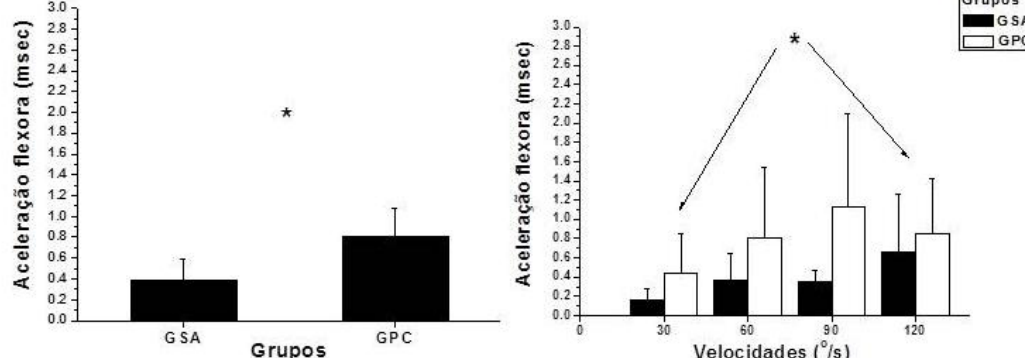
Figura 6. Média e desvio padrão da aceleração flexora nos grupos GSA e GPC e média e desvio padrão da aceleração 30, 60, 90 e 120°/s. * diferença estatisticamente significante entre grupos e velocidades 30 e 120°/s.